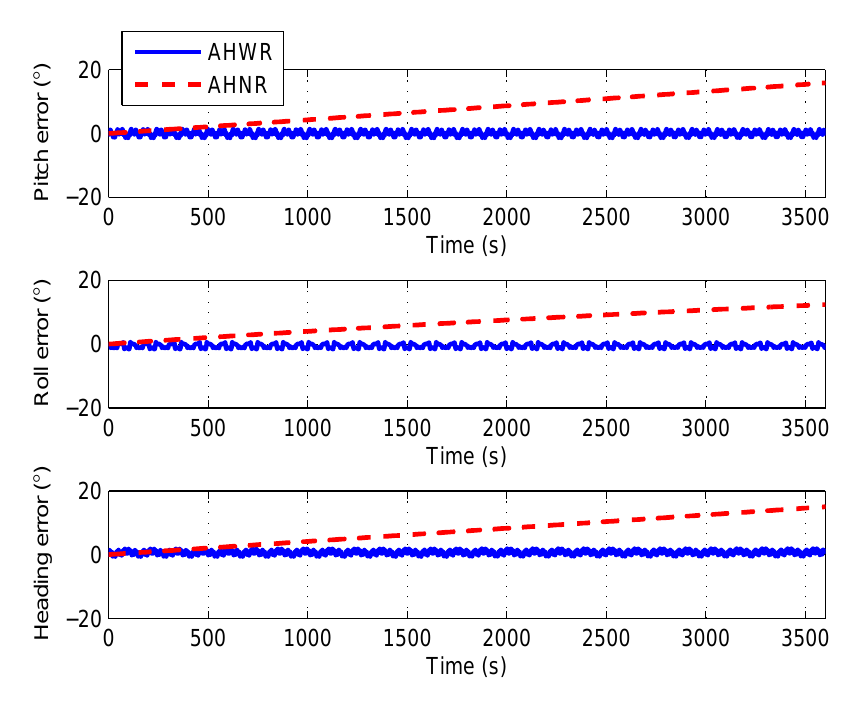
Figure 5. Attitude and heading errors comparison between attitude and heading sensing with rotations (AHWR) and attitude and heading sensing without rotations (AHNR) with constant gyroscope biases, scale factor errors, and axis misalignment